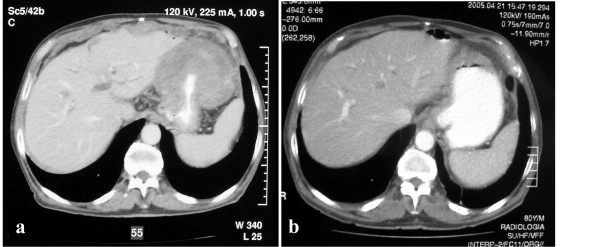
Axial contrast-enhanced CT scan at diagnosis (a) showing a heterogeneous mass encasing the stomach in the upper left quadrant, and diffuse multiple omental nodules; (b) axial contrast-enhanced CT scan after 8 cycles of pemetrexed showing a partial response with a significant shrinkage of the tumour mass and disappearance of the omental nodules.